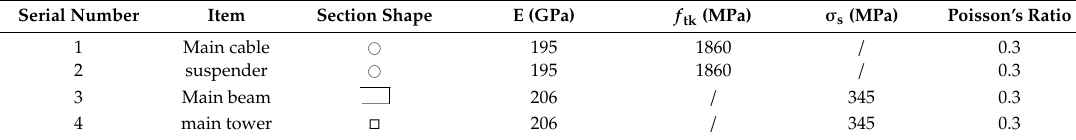
Figure 11. Finite element model of test bridge. Table 2. Main material parameters.